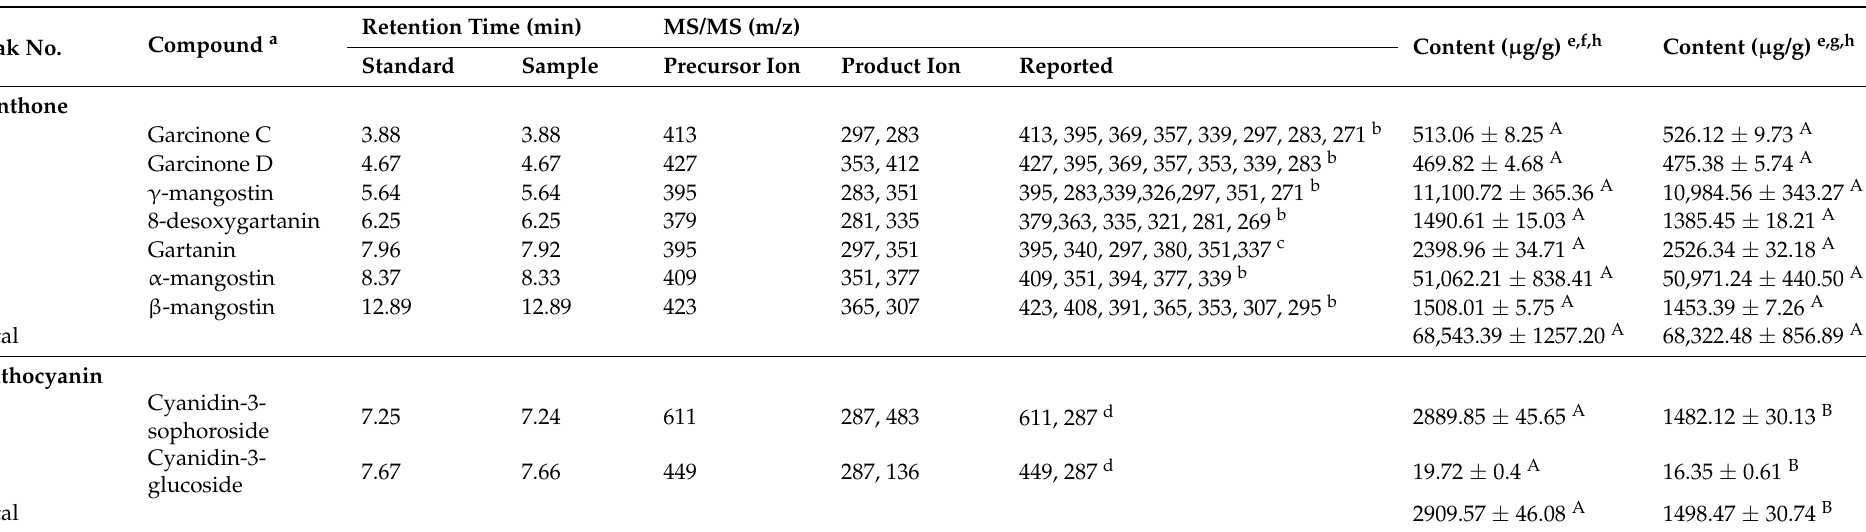
Table 1. Identification data of xanthone and anthocyanin in mangosteen peel extract as well as their contents in dried mangosteen peel extracted by methanol and